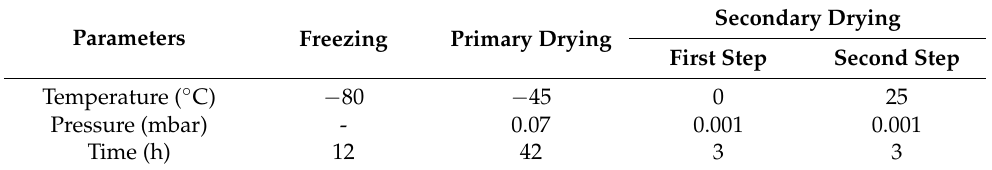
Table 1. Parameters for the lyophilization process of Cu(DDC) 2 -liposomes and/or Cu 2+